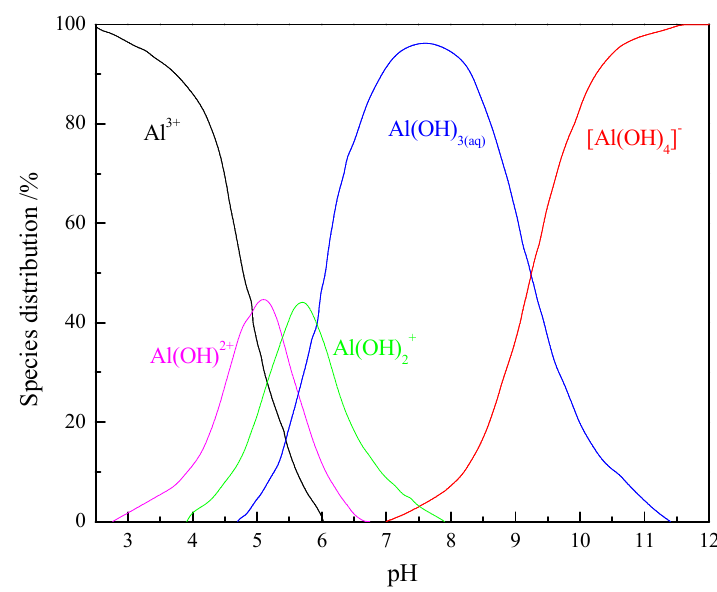
Figure 7. Speciation distribution of monomer aluminum as a function of the pH ( C = 1 × 10 − 4 mol/L).